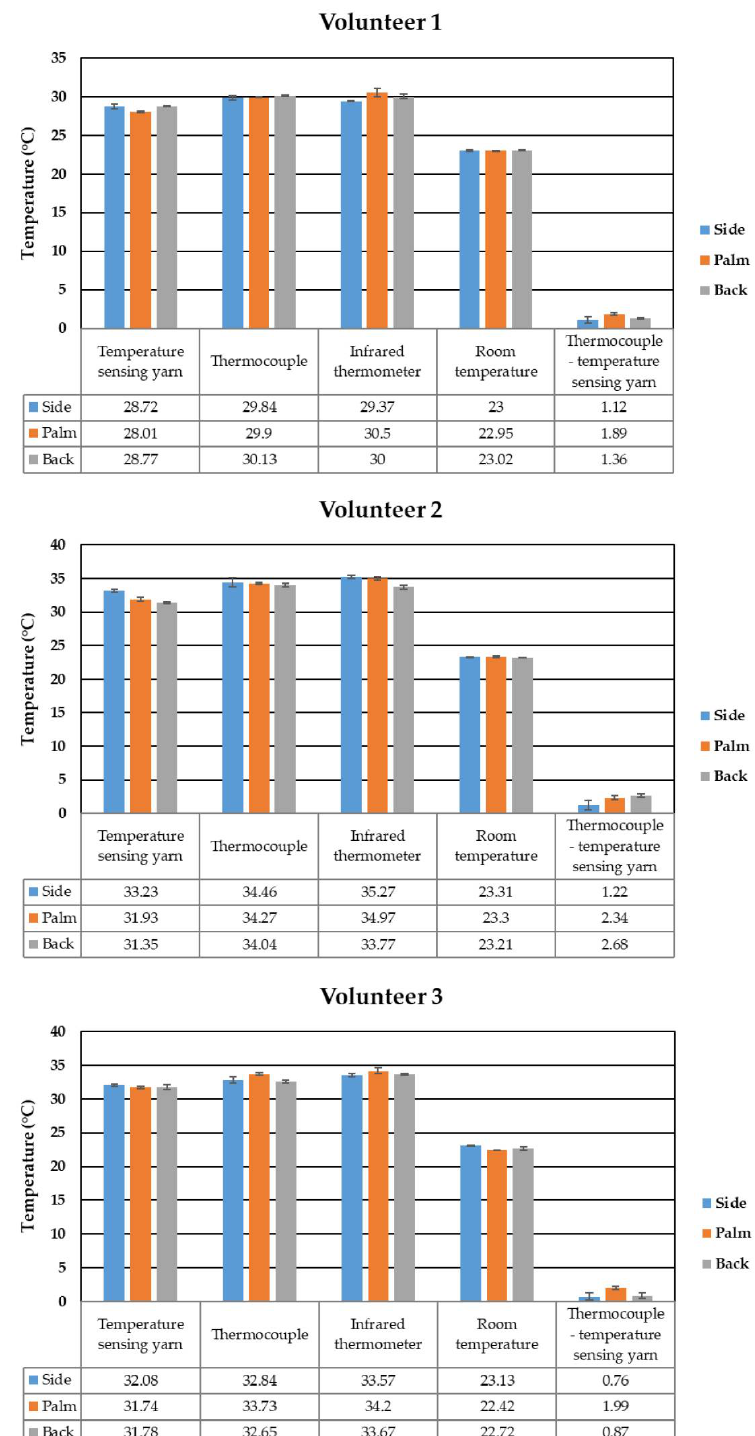
Figure 5. The measurements from the temperature sensing yarn, thermocouple, and infrared thermometer at different positions on the hand for the three different volunteers. The room temperature and difference between the thermocouple and yarn measurements are also presented. ( Top ) On the palm. ( Middle ) On the back of the hand. ( Bottom ) On the side of the hand.